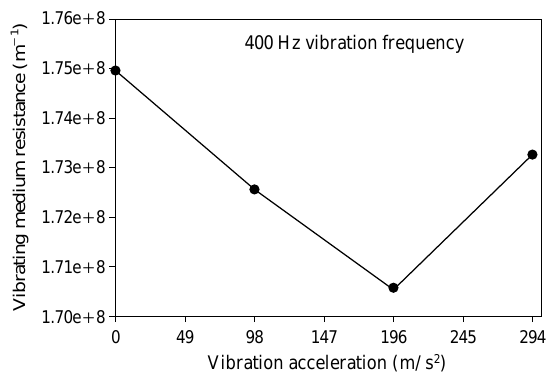
State of the cake and particles during vibration-assisted fil- tration: the effect of increasing acceleration.